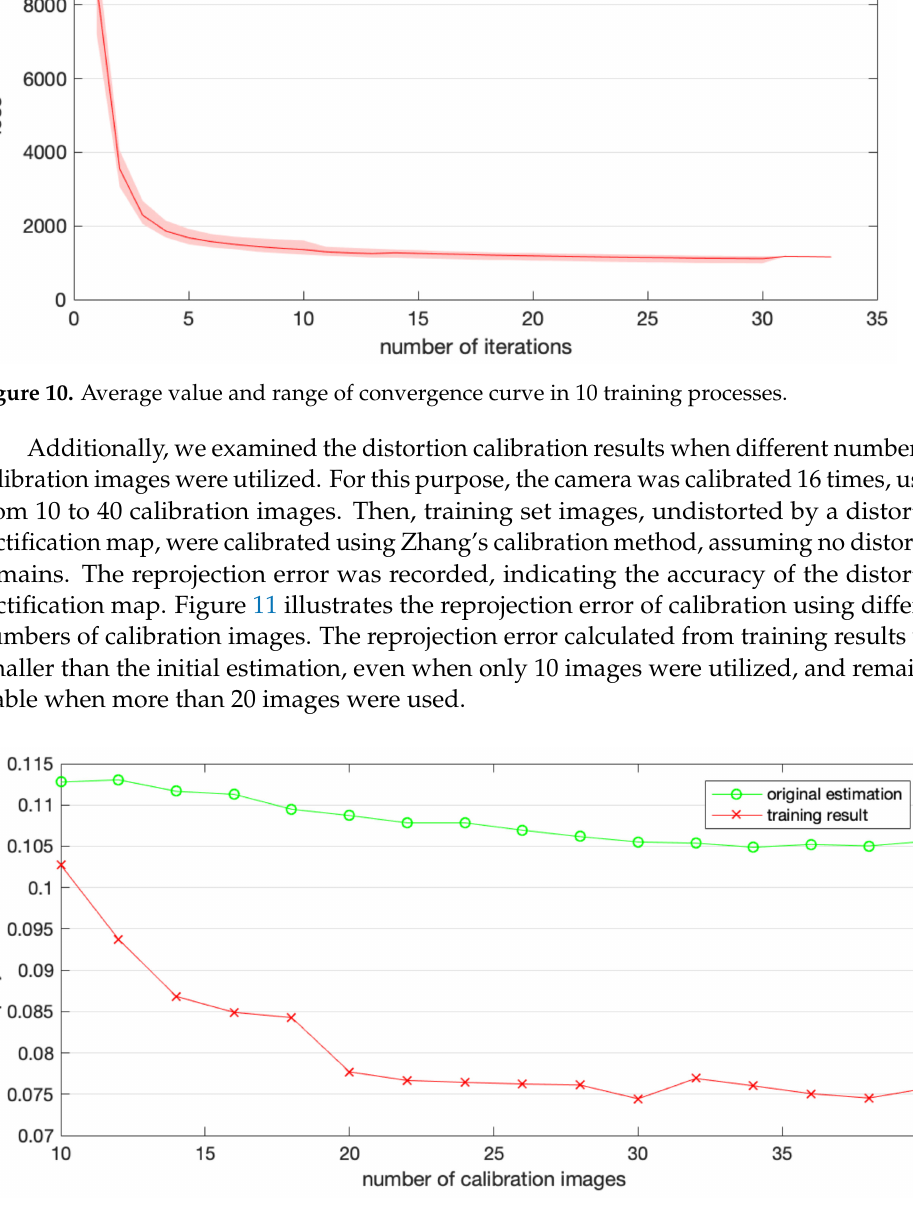
Figure 11. Reprojection error when different numbers of calibration images are